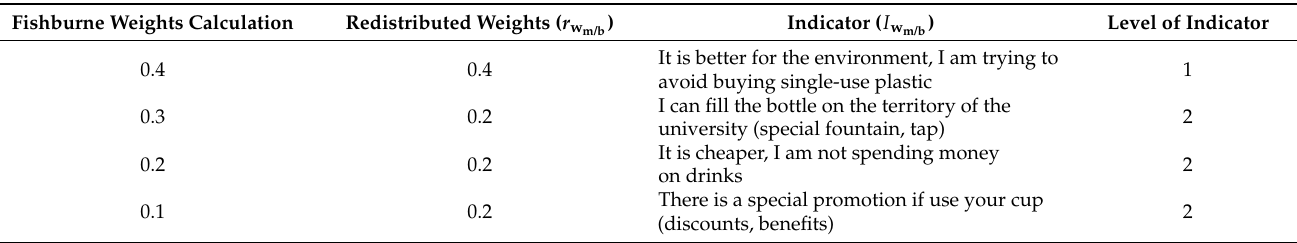
Table 11. Reasoning indicators for consuming